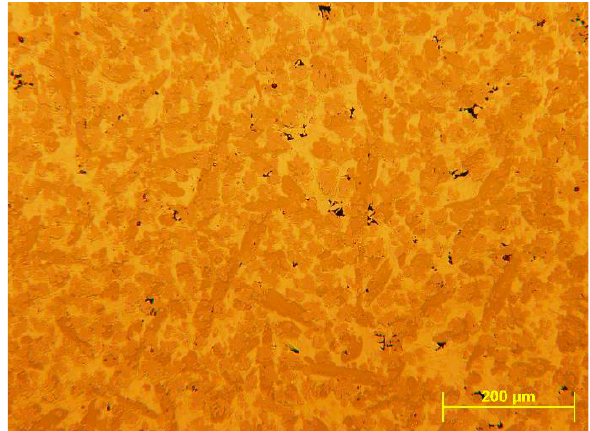
Figure 1. Microstructure of the cast ingot with micro-shrinkages.